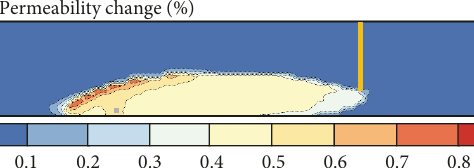
Figure 7: Distribution of altered permeability (%) after 365 days. The changes in permeability were predicted from the following equation − 𝑘 )/𝑘 × 100 ) because its variation was too small. Here, 𝑘 ( 𝑘 󸀠 ( % ) = (𝑘 changed initial initial altered permeability at designated time, respectively.